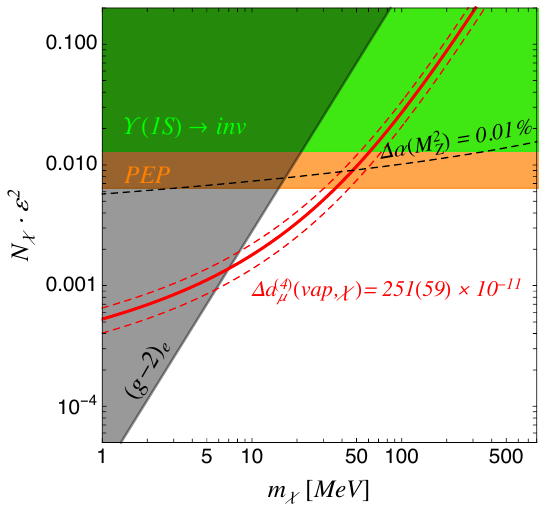
Figure 3 . The two-loop contribution to muon g − 2 from millicharged particles from their one-loop contributions to photon vacuum polarization (red solid lines) and various experimental constraints that only depend on N χ ε 2 . Below the black dashed line, the modification to the fine structure constant at the Z boson mass, α ( M Z ) , is smaller than